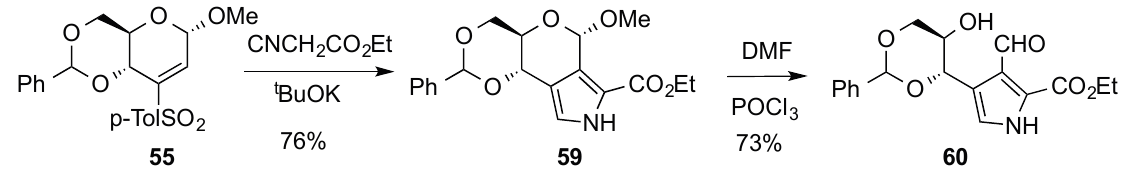
Scheme 14. Synthesis of functionalized chiral pyrrol 60 from vinylsulfone 55